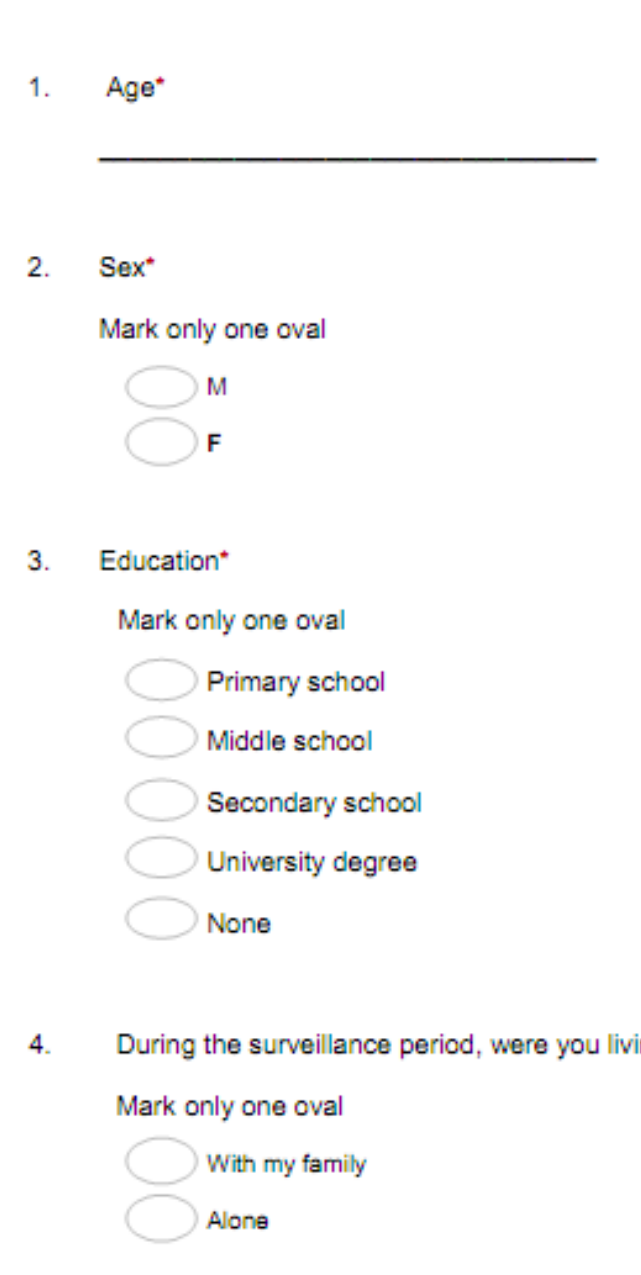
Figure 7. Questionnaire on satisfaction with the service.